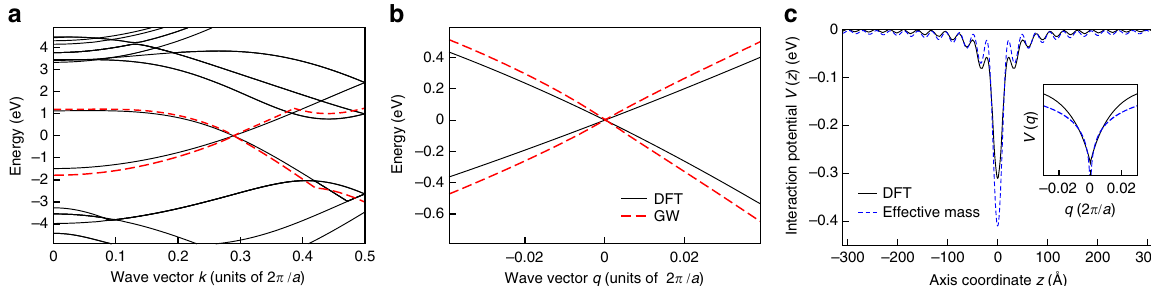
Fig. 2 Electronic properties from many-body perturbation theory. a GW (dashed lines) and DFT (solid lines) band structure of the armchair carbon nanotube (3, 3). b Zoom close to the Dirac point K. The momentum q is referenced from K. c Long-range part of electron – hole interaction V ( z ) along the tube axis according to: DFT (solid line), effective-mass model (dashed line). Inset: interaction V ( q ) in momentum space. V is integrated over the mesh of the q grid and projected onto the conduction and valence bands shown in panel b, with | q | < 0.09(2 π )/ a . The graphene lattice constant is a = 2.46 Å